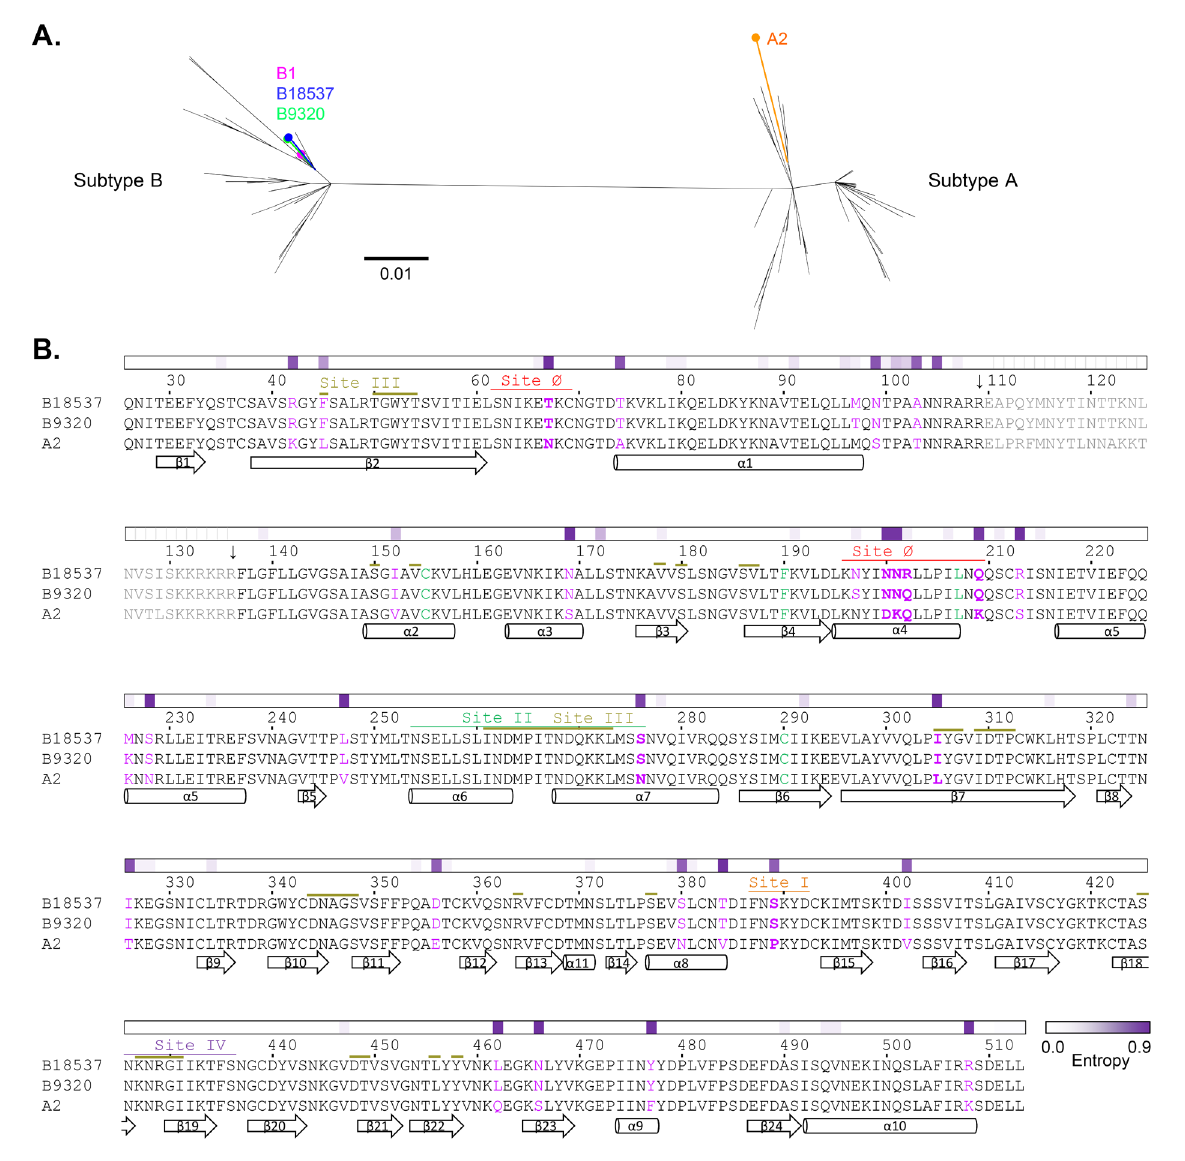
Figure 5. RSV F phylogeny, subtype sequence alignment, secondary structure definition, and sequence entropy. (A) Molecular phylogenetic analysis of RSV F sequences by Maximum Likelihood. The tree was drawn to scale, with branch lengths measured in the number of substitutions per site. Strains B1, B18537, B9320, and A2, are labeled. (B) Sequence alignment of RSV F proteins from B18537, B9320 and A2. Anti- genic sites Ø, I, II, III, and IV are marked above the sequences with color-coded lines. Site III (colored pale yellow) is discontinuous and has substantial overlaps with sites II and IV. Residues that differ between the strains are highlighted in purple and those also found in antigenic sites are highlighted in bold. The DS- Cav1 mutations (S155C, S190F, V207L, S290C) are highlighted in green. Secondary structural elements of RSV F as defined from the B18537 structure are shown below the sequence alignment. Sequence entropy calculated from 190 RSV F sequences is plotted above the sequence with a color gradient according to the color key shown at the lower right. Residues between 2 arrows (residues 110-136) are removed by protease digestion and therefore not present in the mature